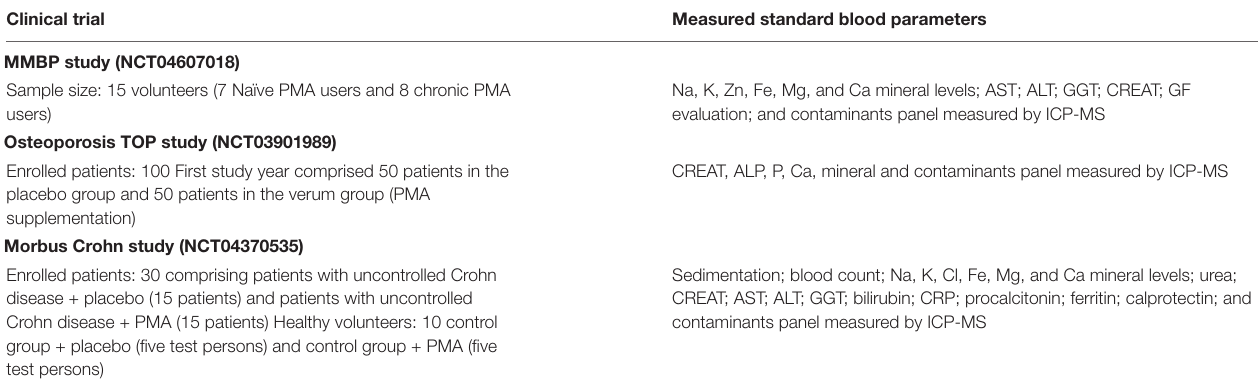
TABLE 1 | Blood parameters evaluated in the Mineral Metabolism and selected Blood Parameters (MMBP) study, Osteoporosis “Treatment of osteoporosis by Panaceo” (TOP) study, and Morbus Crohn study. Clinical trial Measured standard blood